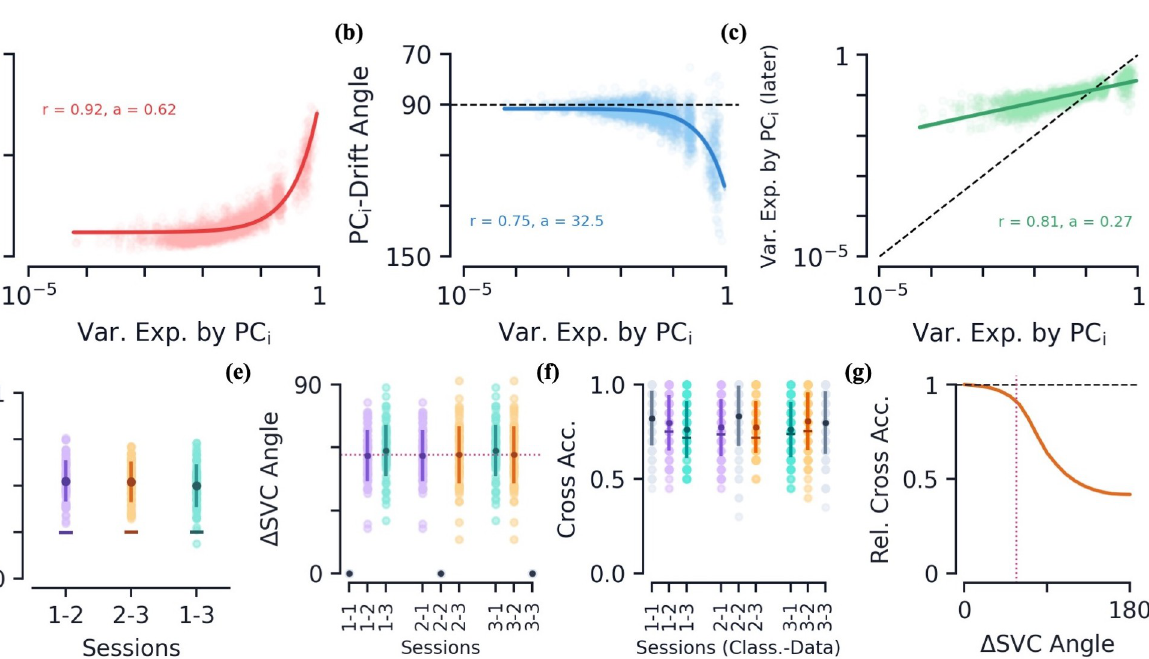
direction relative to full i